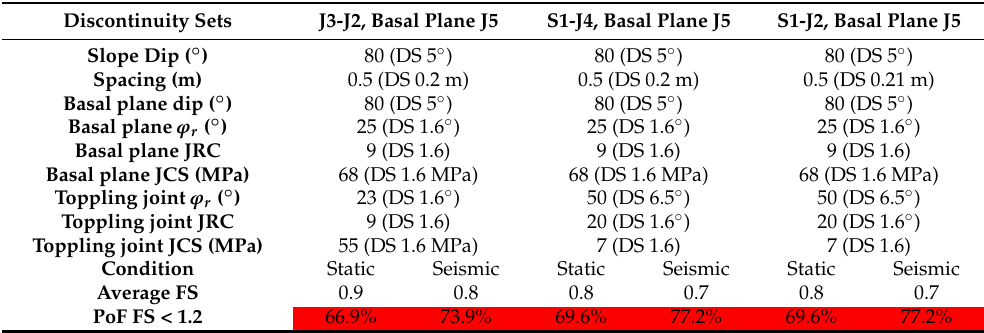
Table 13. Probabilistic stability analysis results for direct toppling.